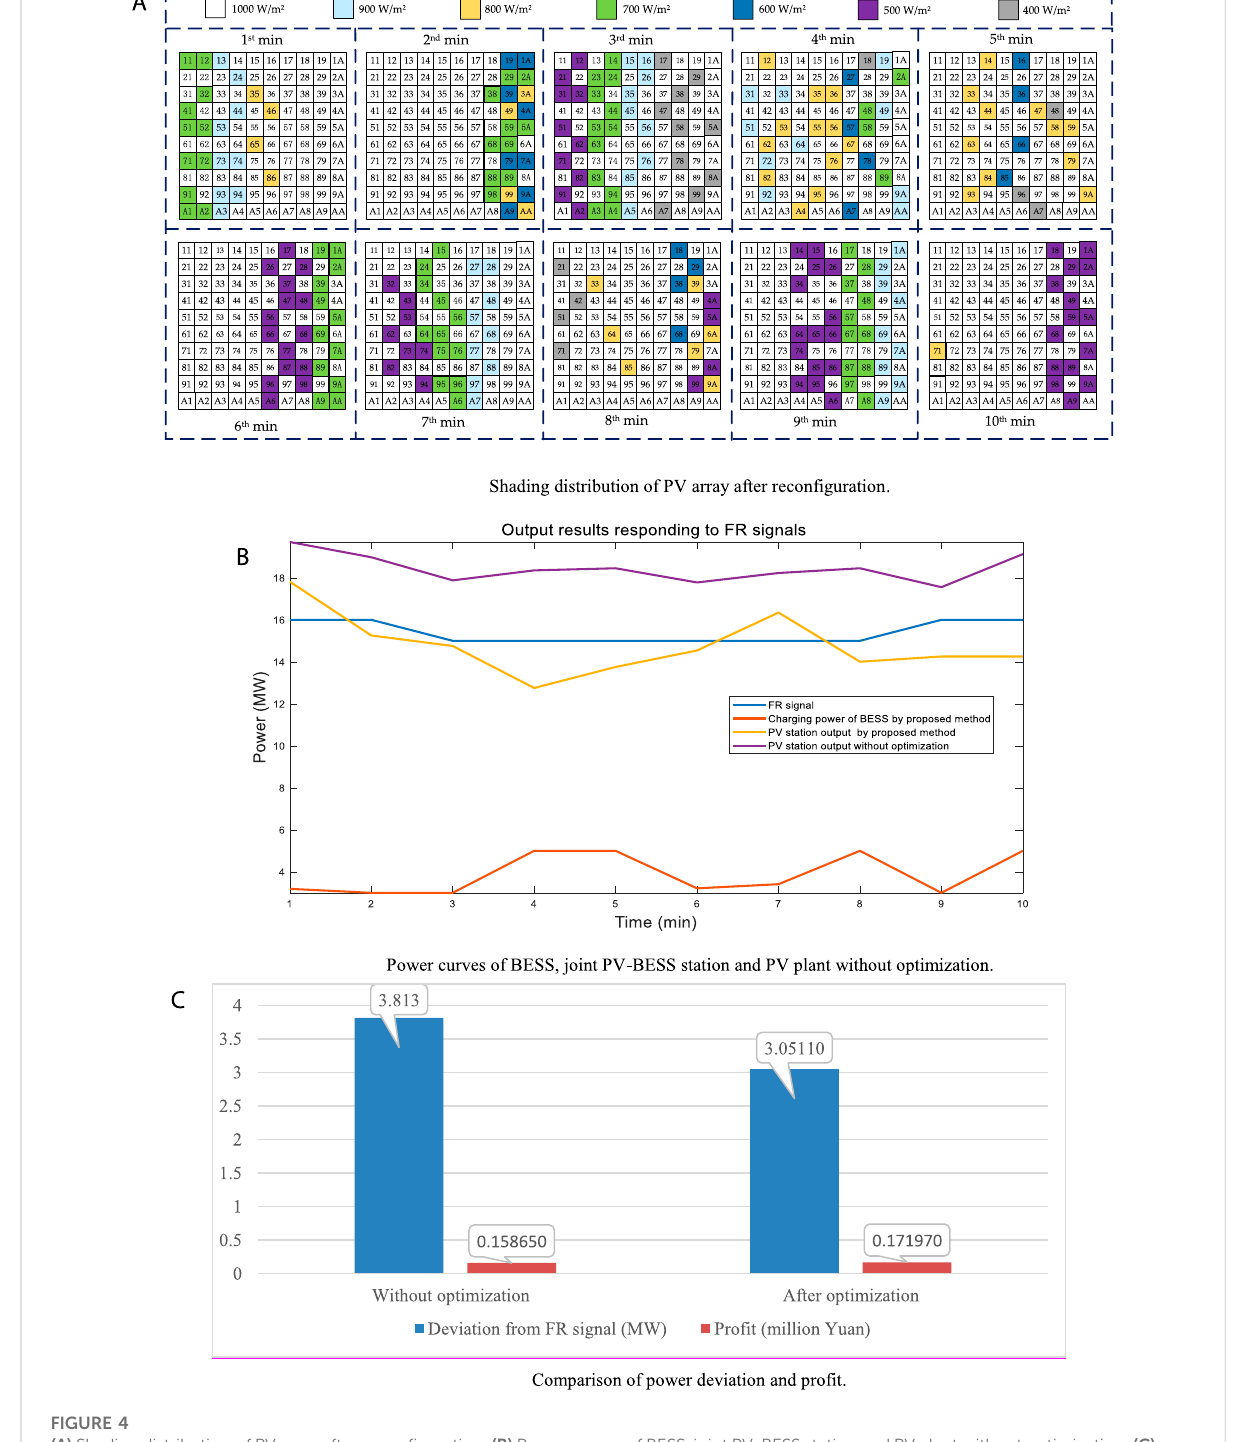
FIGURE 4 (A) ShadingdistributionofPV arrayafter recon fi guration. (B) Power curves ofBESS, jointPV-BESS station andPV plantwithoutoptimization. (C) Comparison of power deviation and pro fi